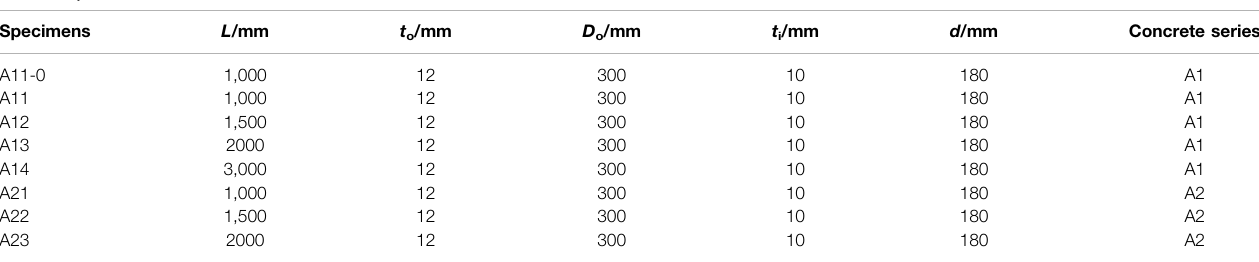
TABLE 2 | Name and size of the tested